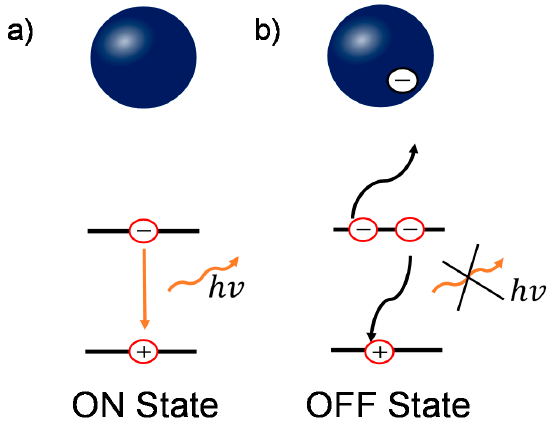
Figure 5. Schematic diagrams of the relationship between the charged grains and blinking behavior in perovskite. ( a ) In the uncharged states, the dominant recombination pathway is bi-molecular recombination; ( b ) In the charged states, the non-radiative three-carrier Auger recombination plays an important role. Blue ball represents an individual perovskite grain.